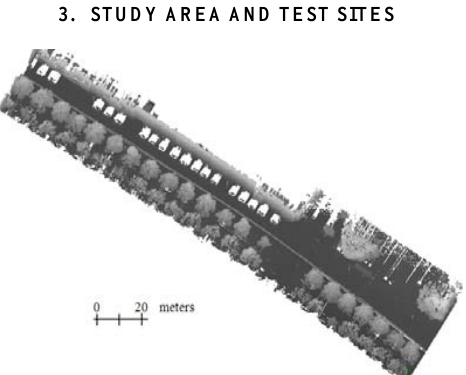
Figure 1. Sample area of study data set